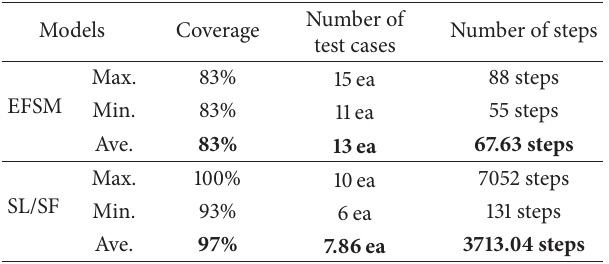
Table 2: Test case generation